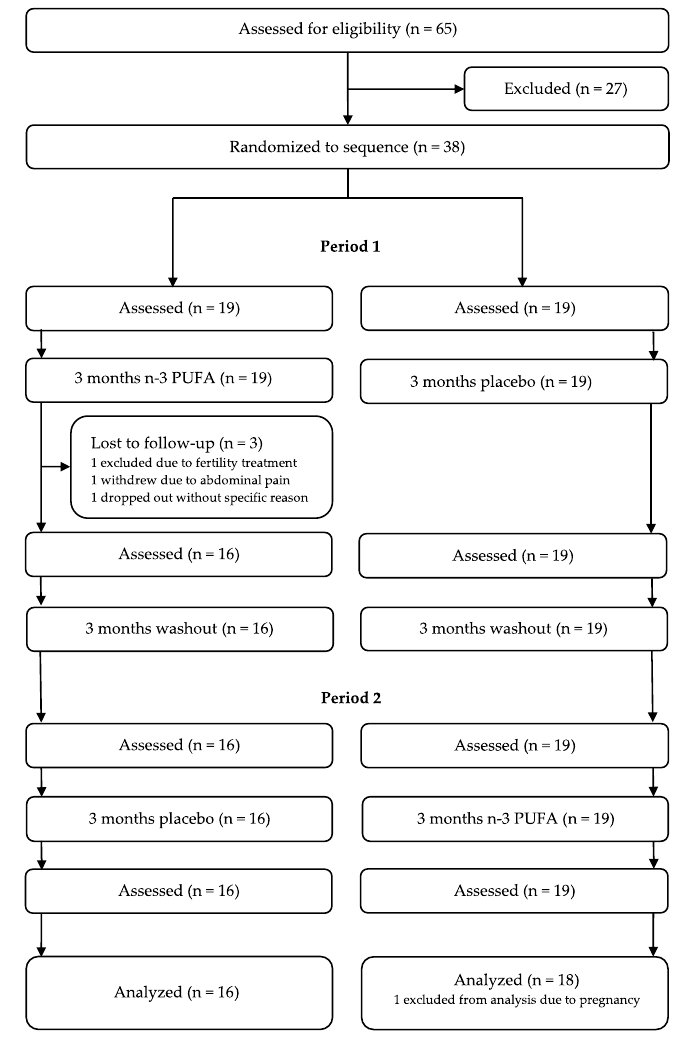
Figure 2. Participant flow diagram. N-3 PUFAs: omega-3 polyunsaturated fatty acids.